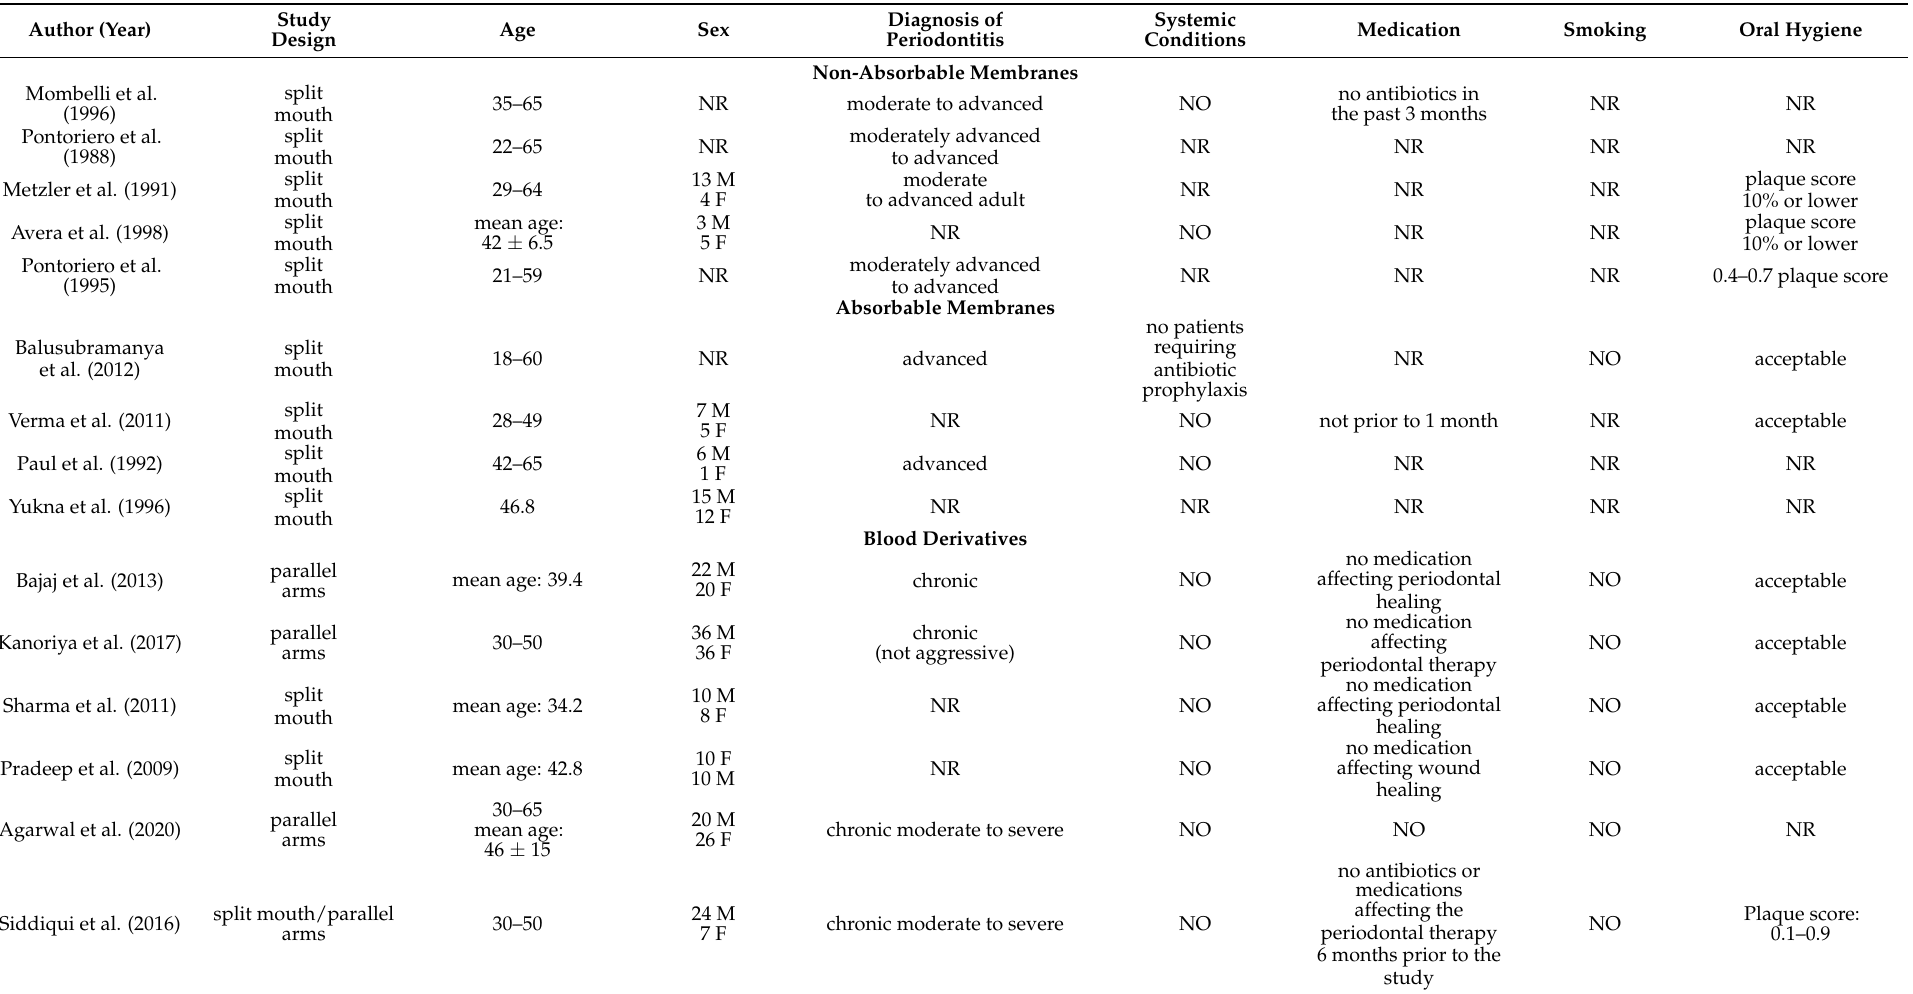
Table 2. Study design of the included